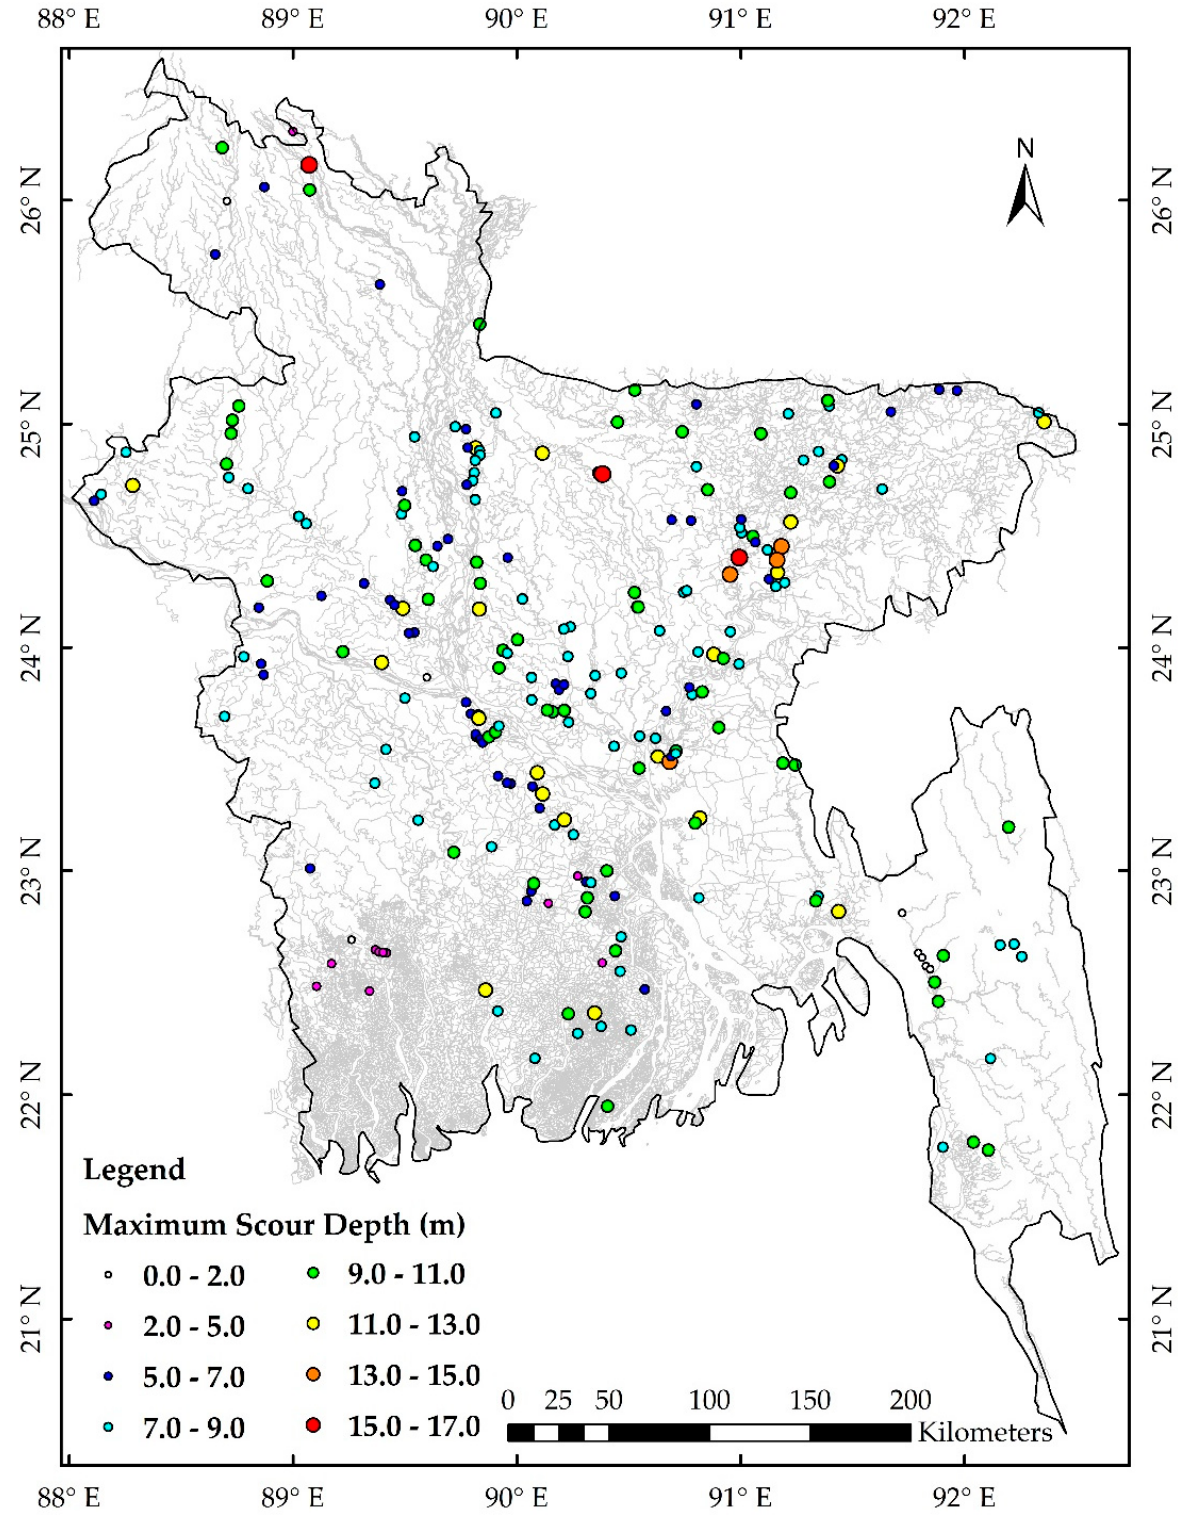
Figure 6. Variation of the local scour depths in the Bangladesh rivers.